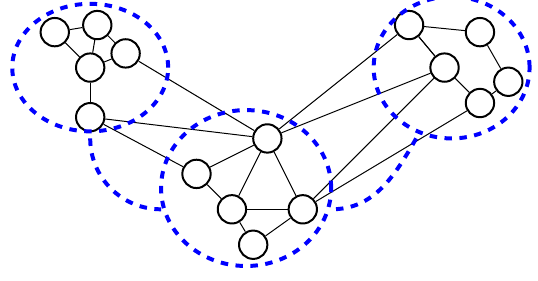
Figure 5. Adjacency structure of the segment-graph. The edges between points are represented in black , the segmentation and the adjacency of its components in blue: . between segments, while w encodes the weight of their